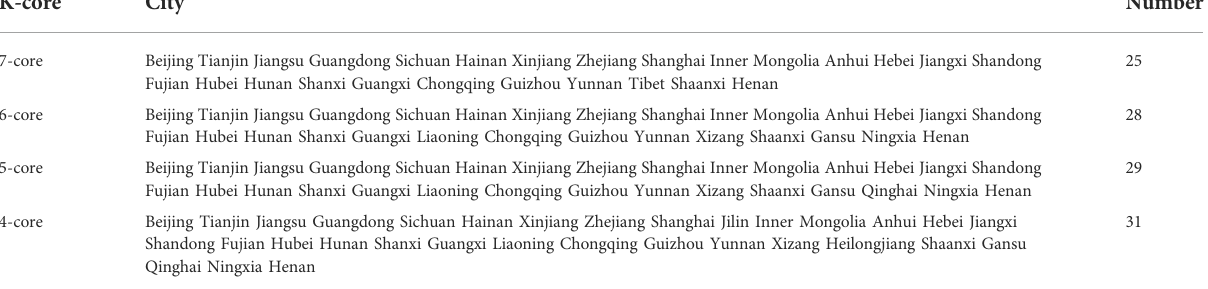
TABLE 5 K-core analysis of the network of green fi nancial development on the impact of industrial structure upgrading. K-core